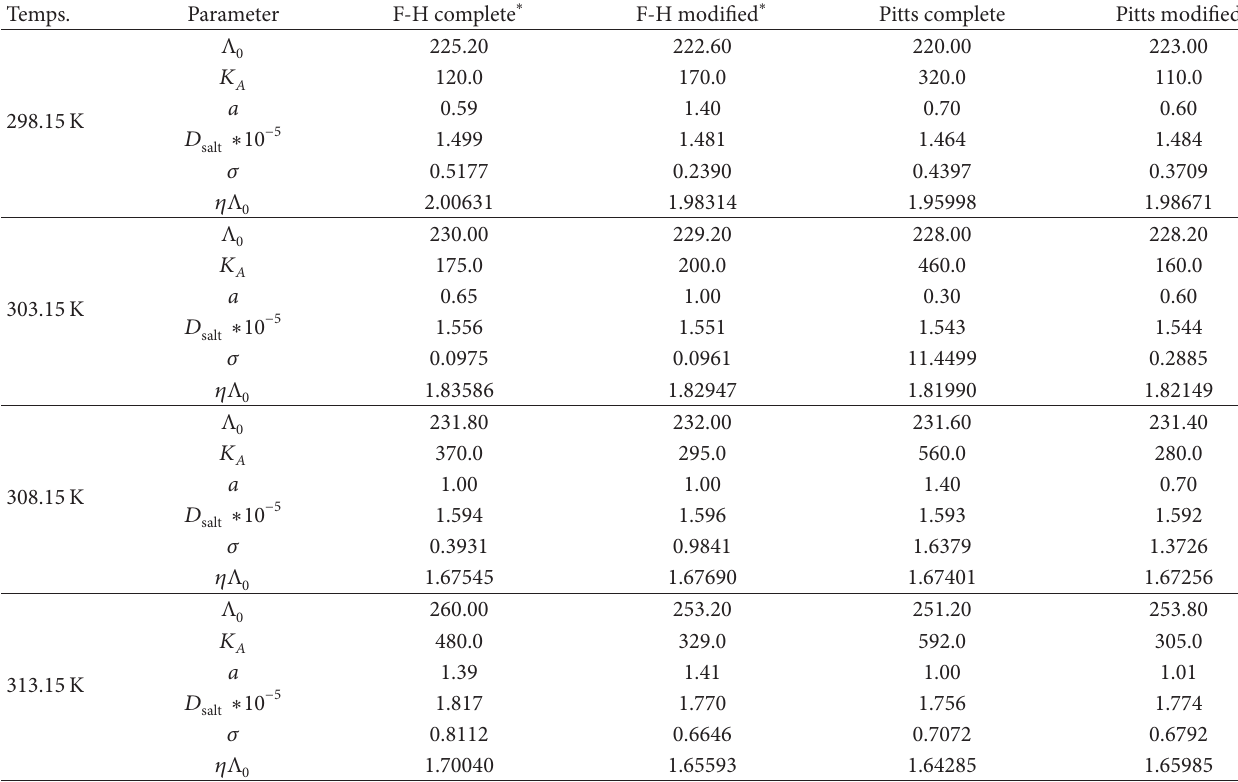
T 7: Best �t results for